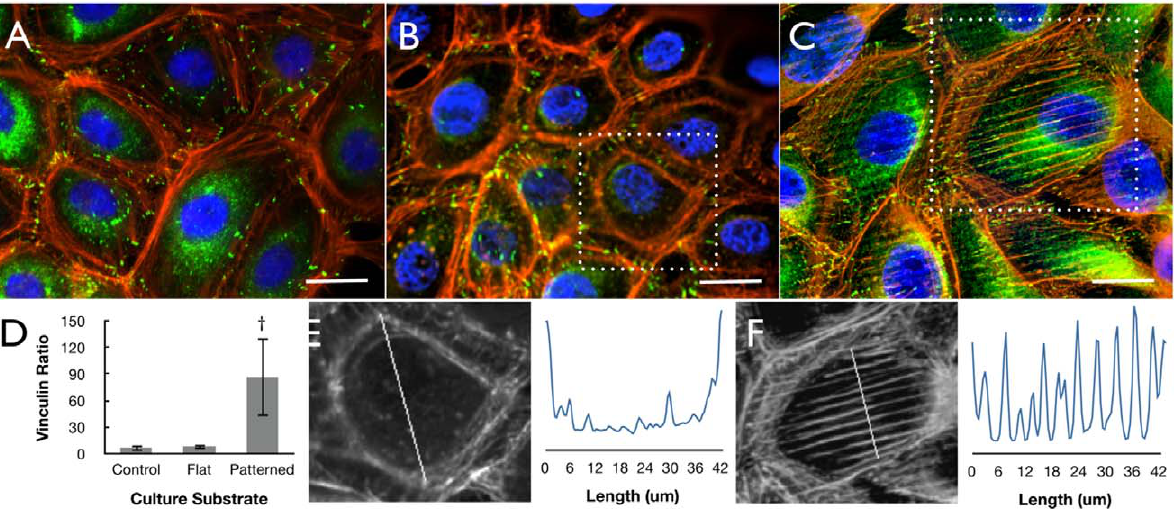
Figure 6. Cytoskeletal alignment to silk substrate topography. Fluorescent microscopy images of HCLE cells on (A) glass, (B) flat silk, and (C) patterned silk surfaces (nuclei - blue, actin – red, and vinculin - green, scale bars=20- m m). (D) Quantification of intracellular to cellular periphery FA formations as indicated by vinculin staining. Fluorescent images and corresponding line-scan analysis of actin fiber distribution of HCLEs cultured on (E) flat and (F) patterned silk film surfaces, where the inset white line of each image indicates region of analysis.